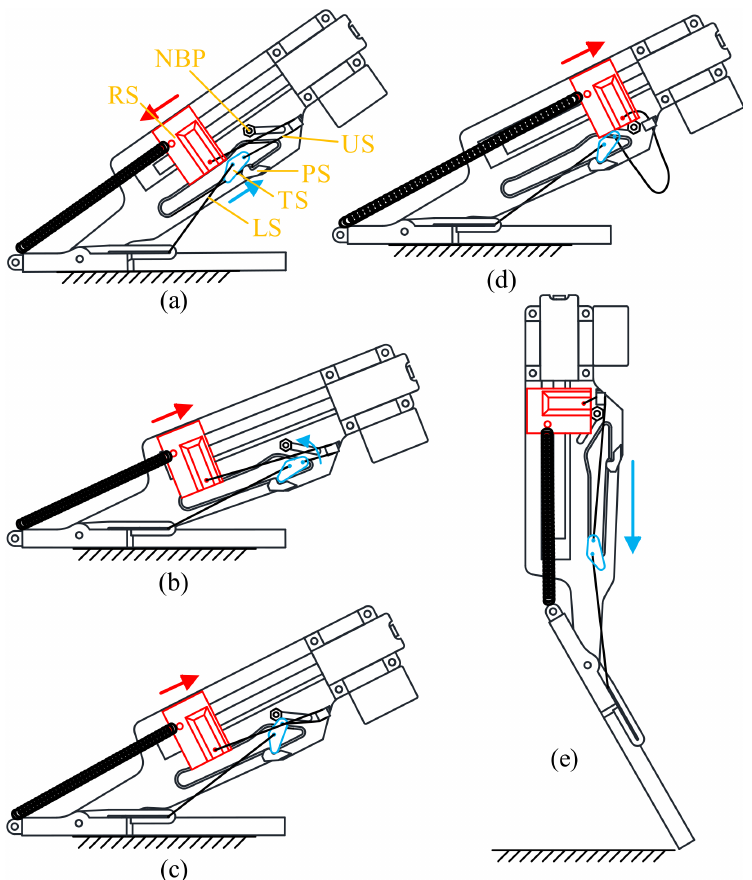
Figure 3. Five typical stages of the mechanism with some components marked: ( a ) the RS moves downwards and pulls the TS moving upwards through the US; ( b ) the RS moves upward and the TS reaches the L-shaped PS, whereupon it rotates because of the unbalanced torque; ( c ) the RS continues to move upward and the pole is unable to rotate because of the pull provided by the LS; ( d ) the RS continues to move upward, pushing the NBP upward in its guide rail; ( e ) the TS falls freely down through its guide rail and the mechanism executes the launching